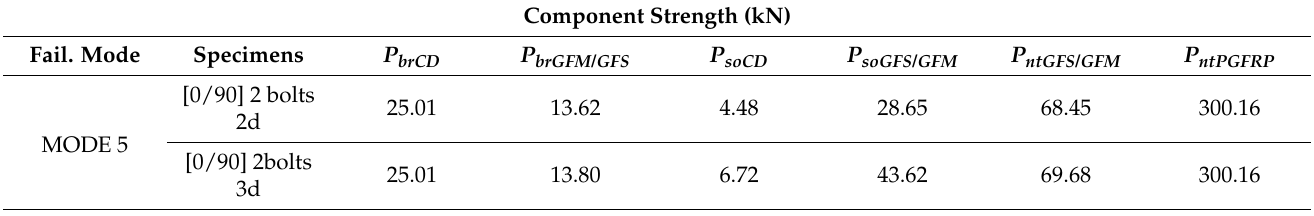
Table A3. Component